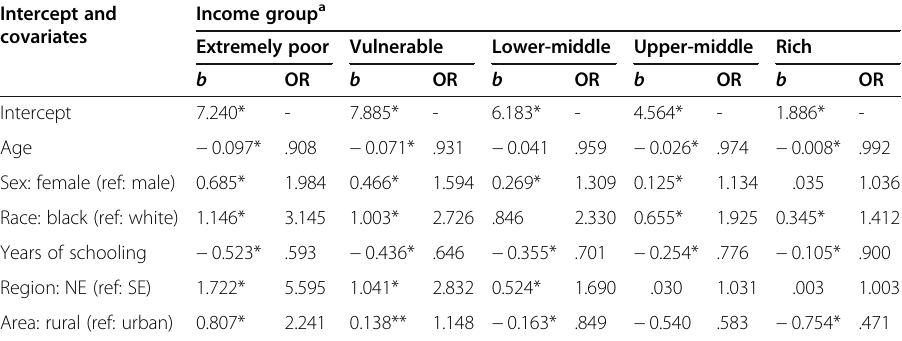
Table 5 Multinomial logistic regression of selected variables on the relative income groups — Northeast (NE) and Southeast (SE) regions, Brazil, 2015 Intercept and Income group a covariates Extremely poor Vulnerable Lower-middle Upper-middle Rich